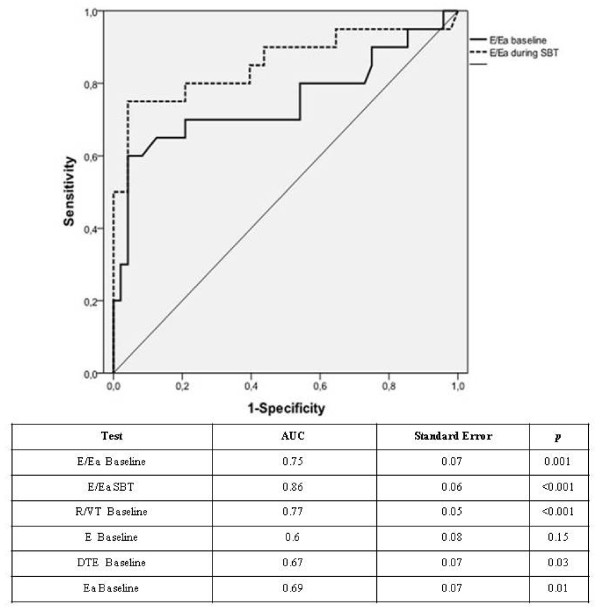
ROC curves for E/Ea measured at baseline and during the SBT to predict weaning failure. This figure shows ROC curves for E/Ea measured before SBT in solid line and E/Ea measured 10 minutes after starting the SBT in dashed line to predict weaning failure. AUC for protodiastolic annulus mitral velocity (Ea), Protodiastolic mitral velocity (E) wave its deceleration time (DTE) and ratio of respiratory rate/Tidal volume (RR/VT) are summarized in the table under ROC curves. AUC, Area under the ROC curve.